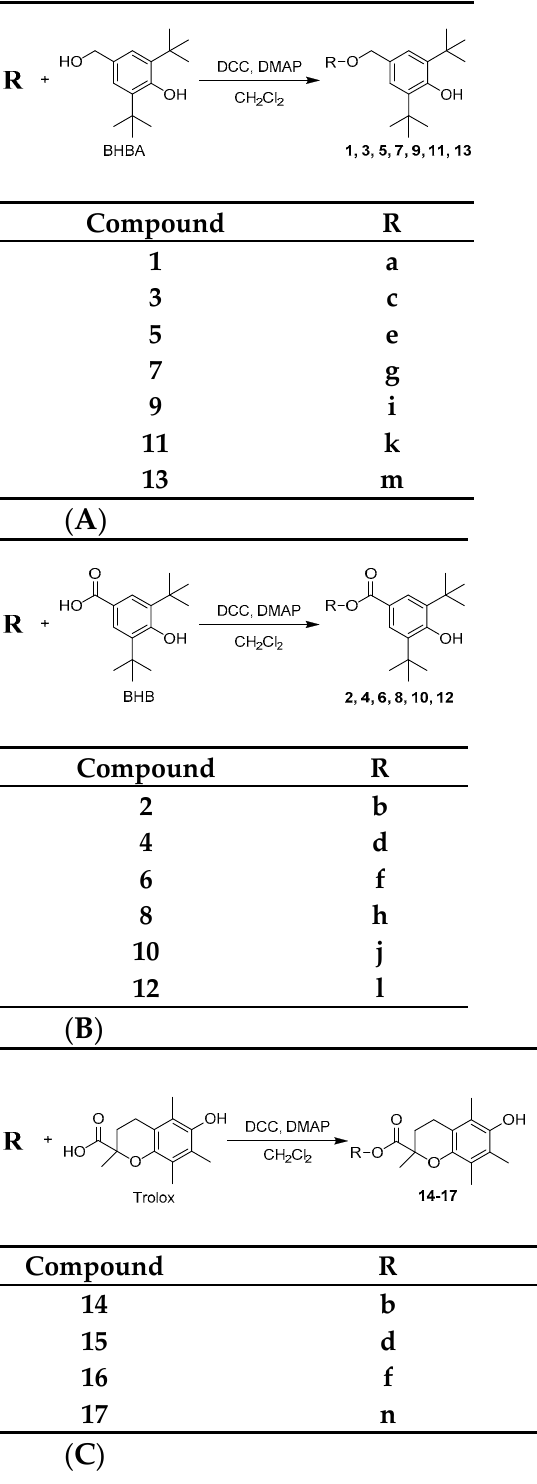
Figure 2. ( A ) Synthesis of derivatives 1 , 3 , 5 , 7 , 9 , 11, and 13 ; ( B ) synthesis of derivatives 2 , 4 , 6 , 8 , 10 and 12 ; and ( C ) synthesis of derivatives 14–17 . ( DCC: N,N’-dicyclohexylcarbodiimide, DMAP: 4-dime-